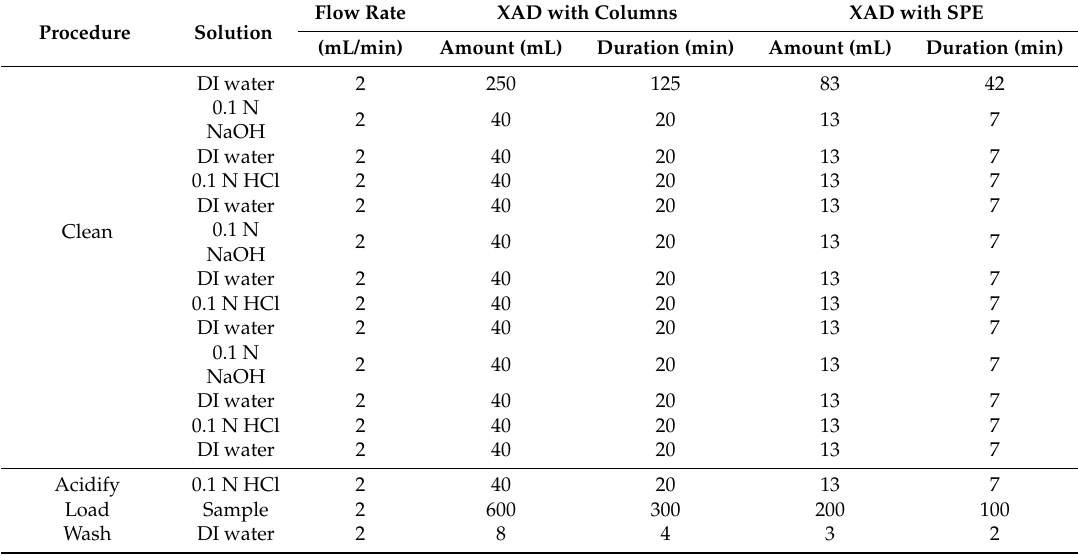
Table 1. Procedures of DOM isolation using the combined XAD 8/4 resins with columns and with SPE